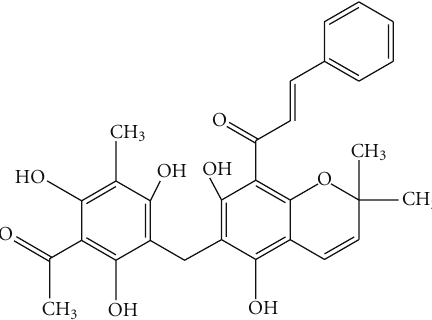
Figure 1: Chemical structure of